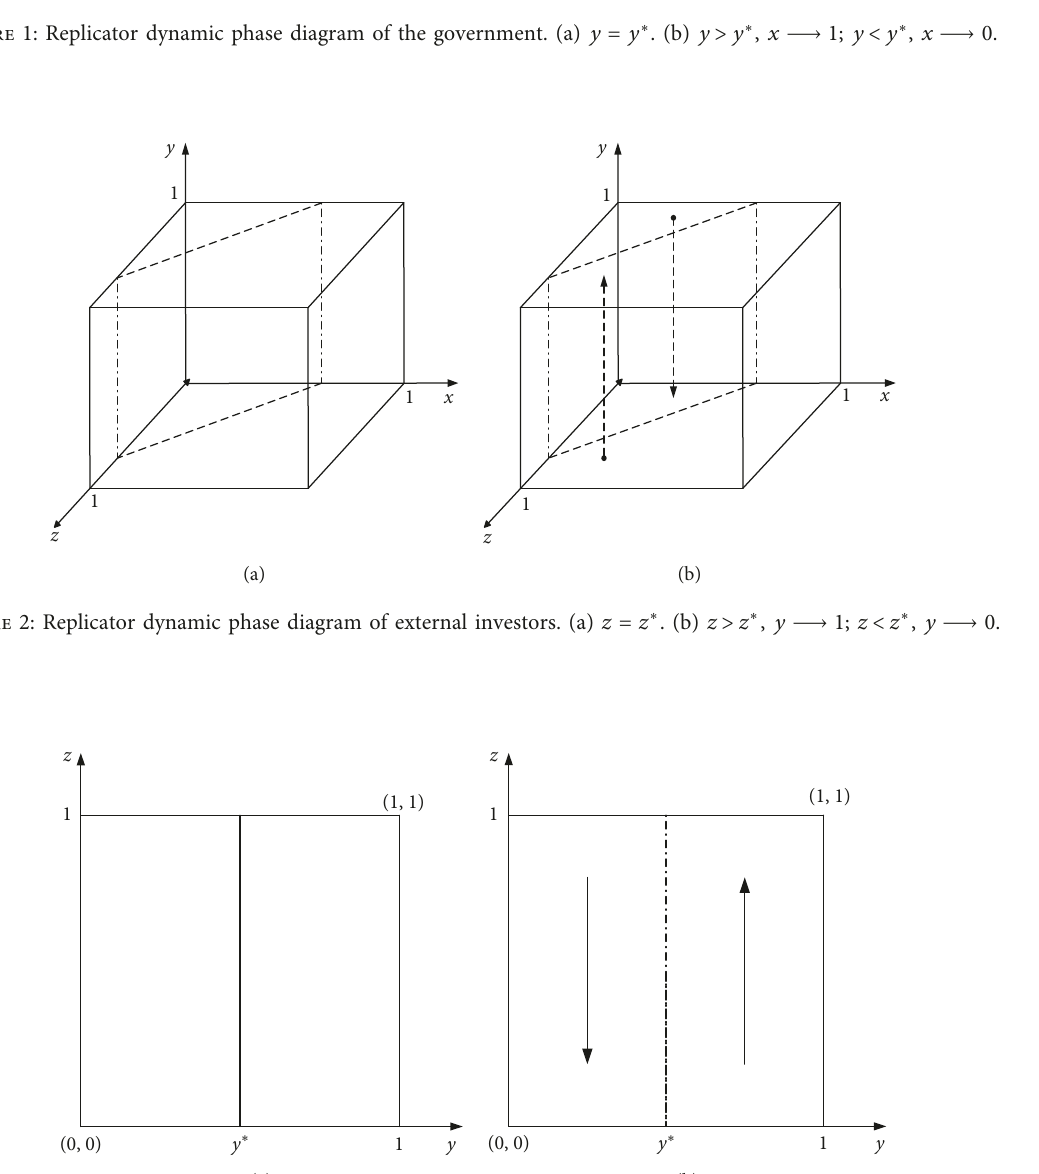
Figure 1: Replicator dynamic phase diagram of the government. (a) y